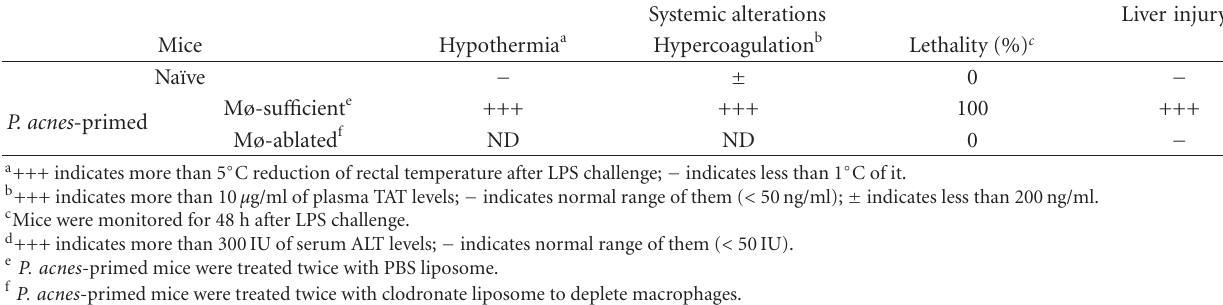
(Figure 6). Blockade of IL-18 or genetic depletion of Il18 can protect against the liver damages [17, 54] (Figure